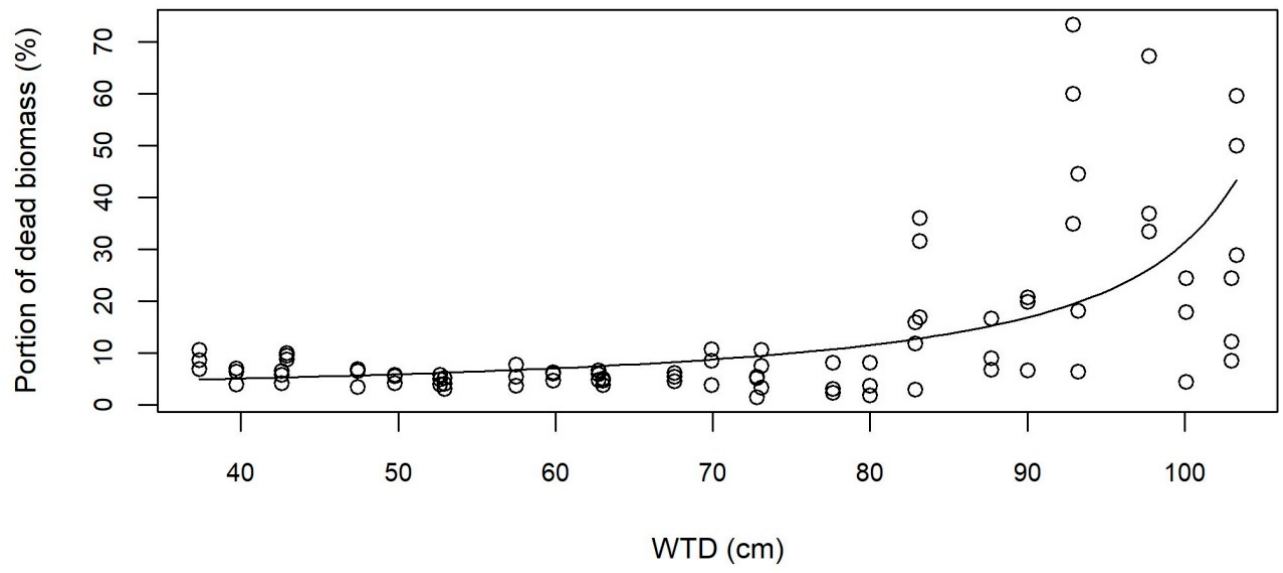
Figure 6. Portion of dead biomass of cup plant at the end of the second growing season (September 2019) depending on water table distance (WTD). GLM: Gamma- distributed residuals, p < 0.001, n = 84.